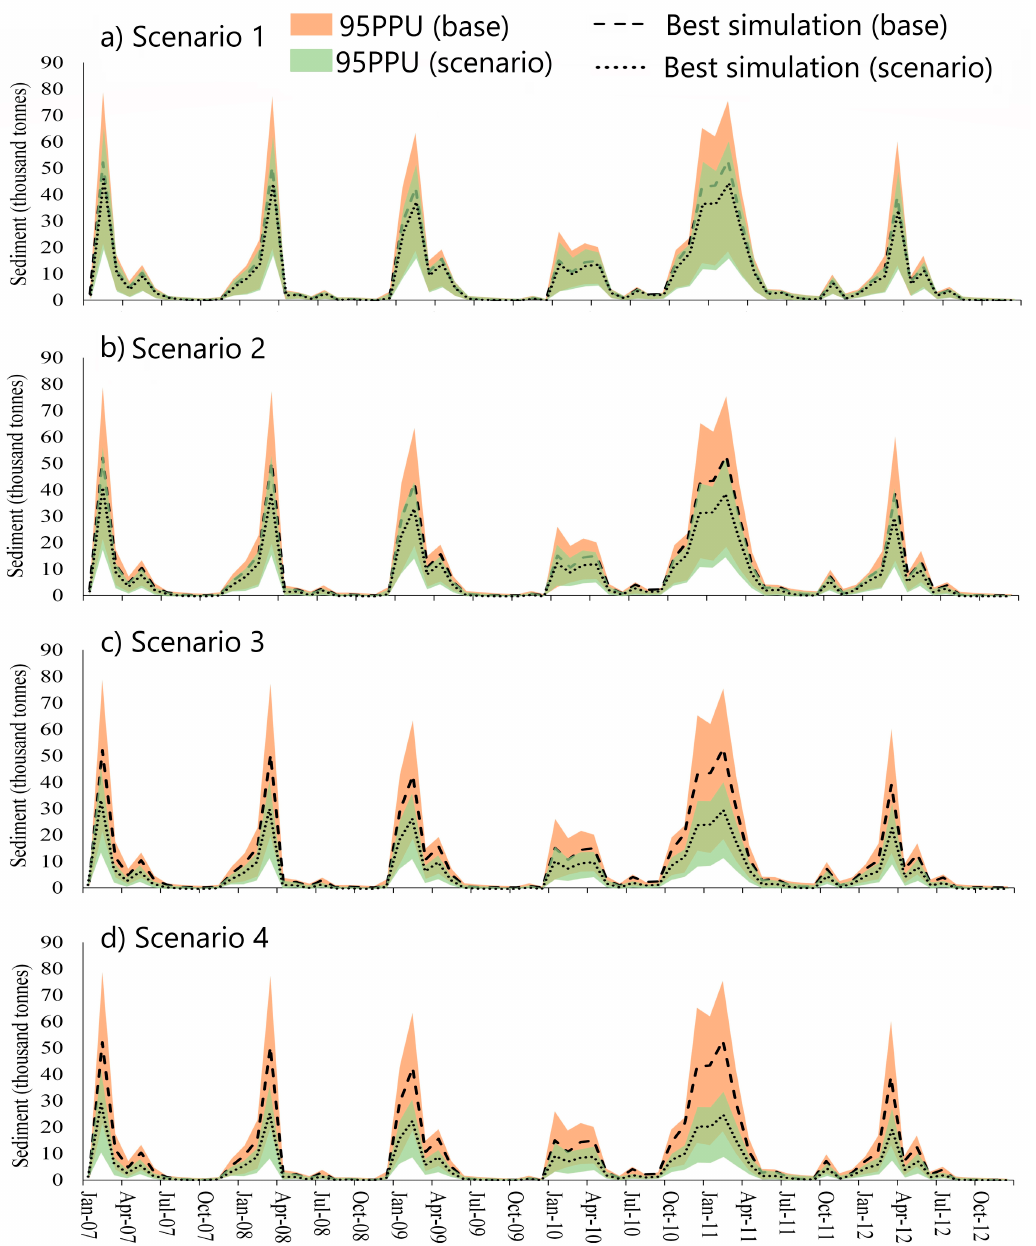
Figure 12. Monthly soil erosion affected under different land use scenarios: ( a ) pasture with slope more than 30% to forest, ( b ) pasture with a slope more than 20% to forest, ( c ) pasture with slope more than 10% to forest, ( d ) all pasture to forest (2007–2012).